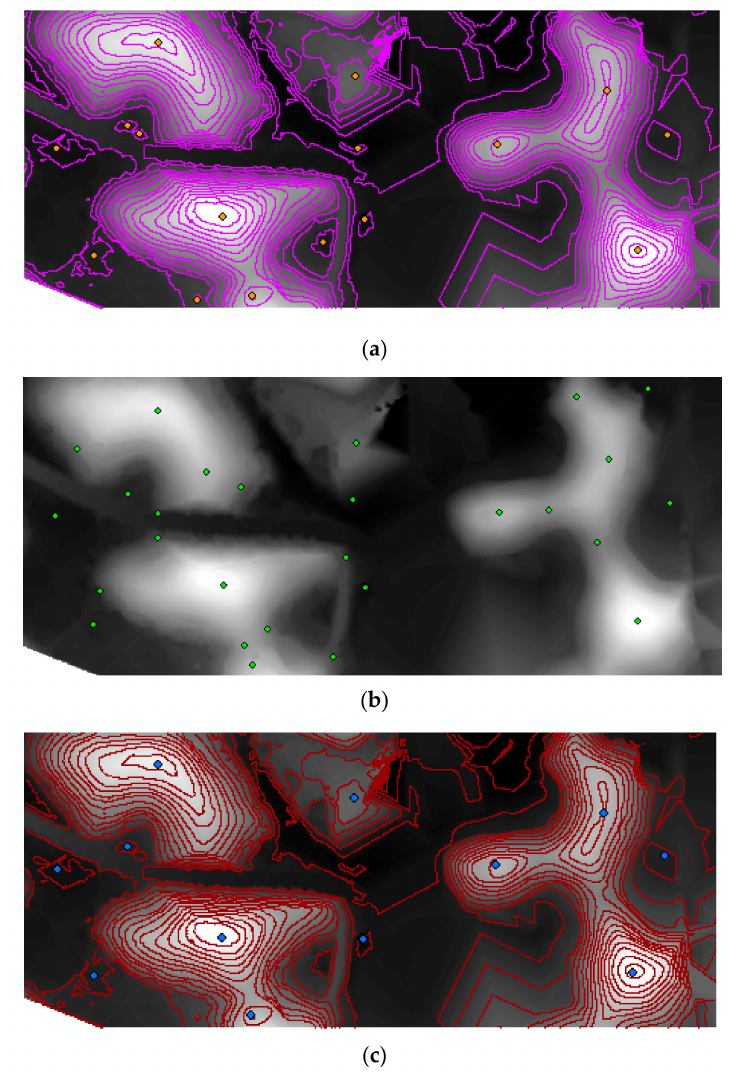
Figure 14. Distribution maps extracted by the traditional Mountain Vertices Extraction Methods using the second dataset. ( a ) Contour Line Method. ( b ) Neighborhood Analysis Method. ( c ) Contour line and Neighborhood Analysis Overlay